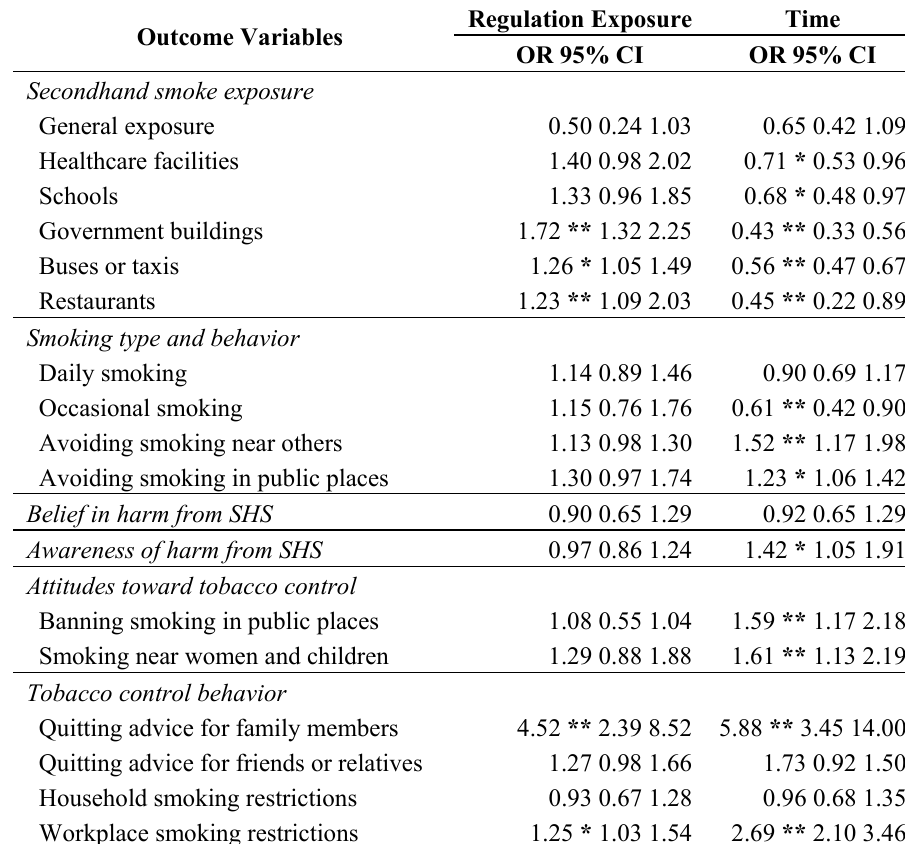
Table 3. Multiple regression results for assessing respective associations between the smoke-free regulation intervention and outcome variables, adjusting for exposure to smoke-free regulations and